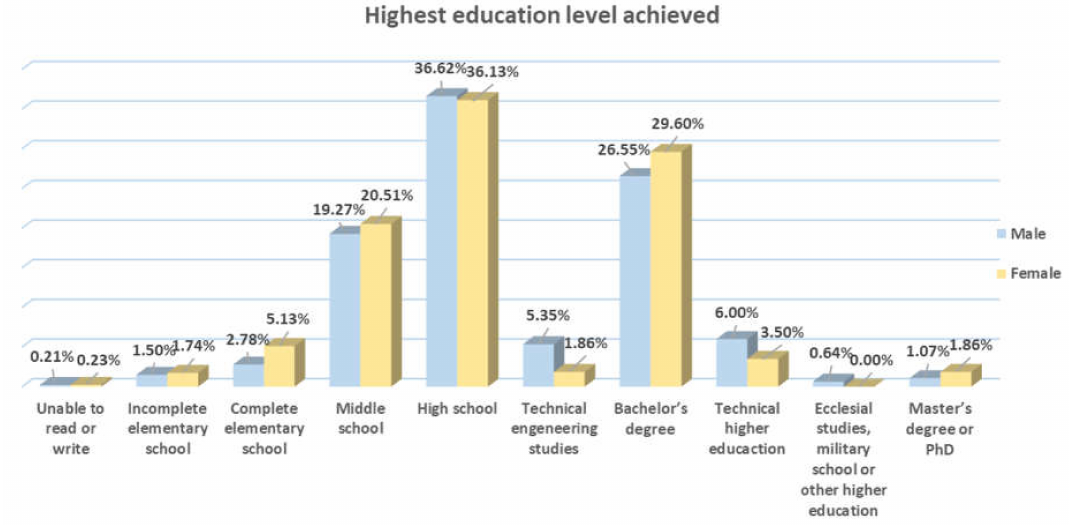
Figure 1. Highest education level